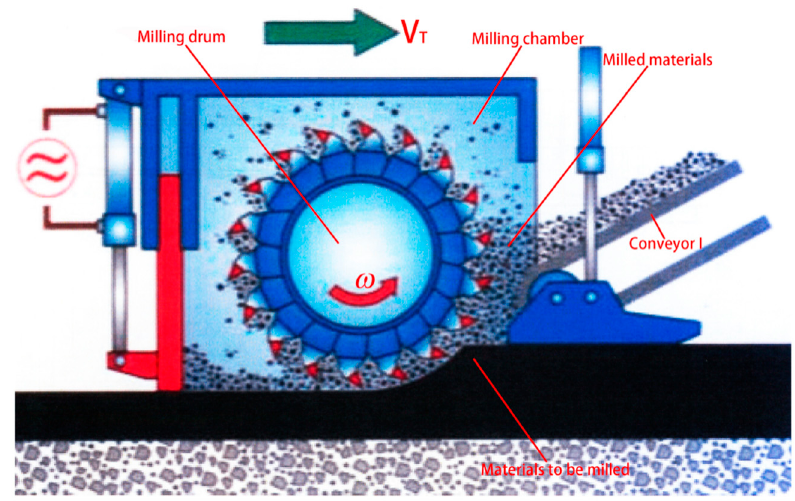
Figure 1. Structure of a cold milling machine.